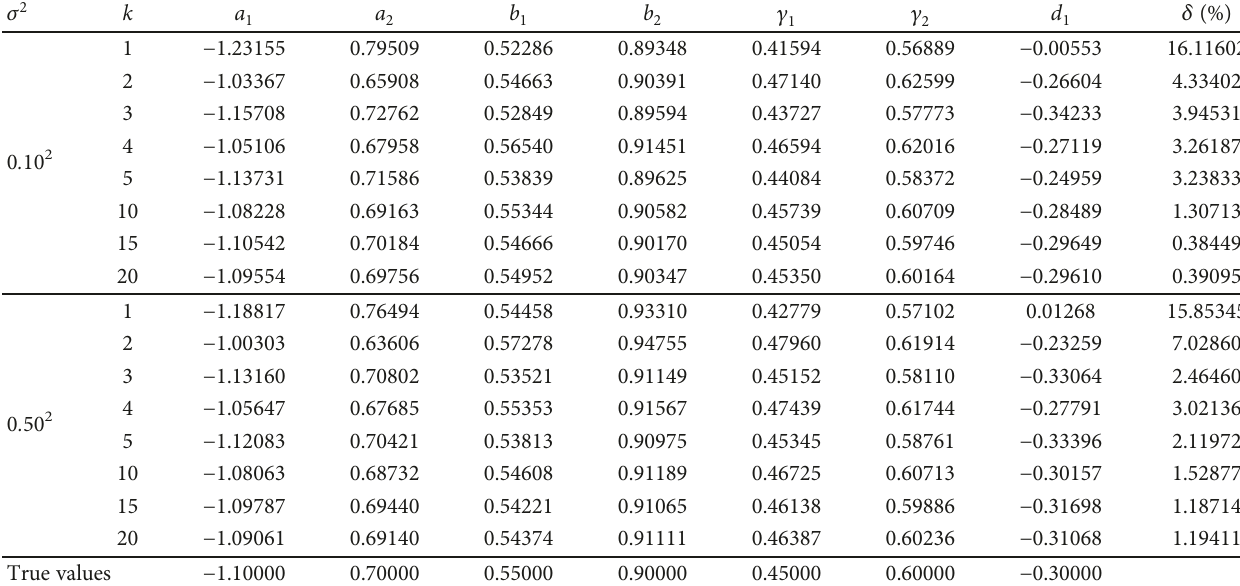
Table 3: The parameter estimates and errors of the D-KT-NI